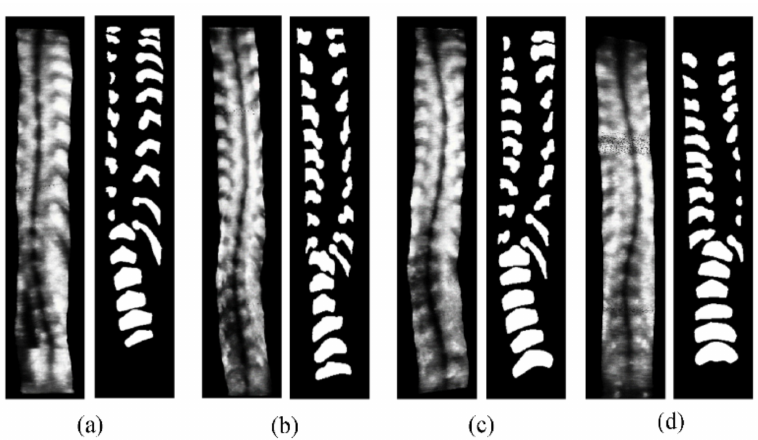
Figure 10. ( a – d ) Four image sets each having a raw image plus a truth